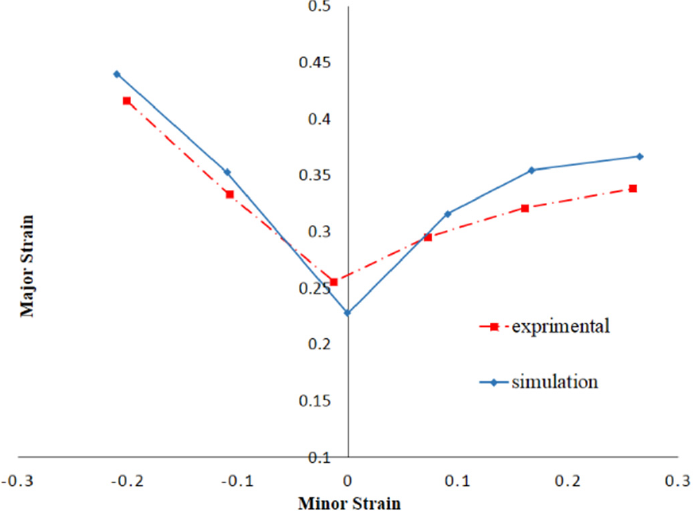
Figure 8. Comparing the experimental and simulated FLDs for a 1 mm-thick AA 6061 sheet at 20 mm/min speed.